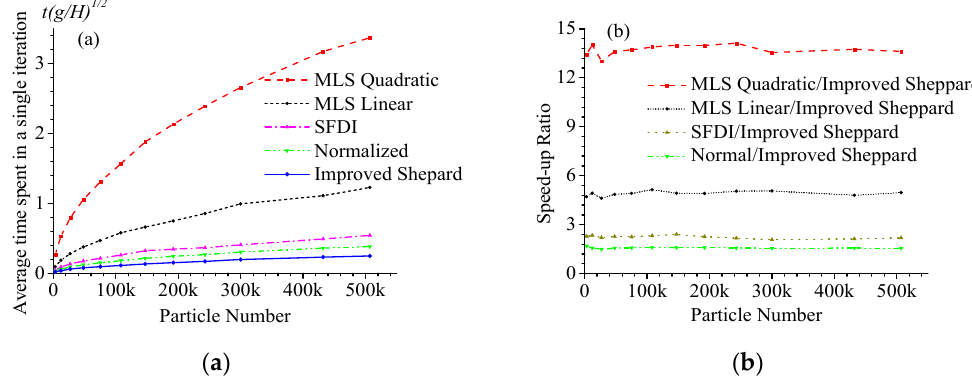
Figure 4. Comparison of the computational efficiency between the improved Shepard and other methods. Average time spent in a single iteration ( a ) and a sped-up comparison ( b ).